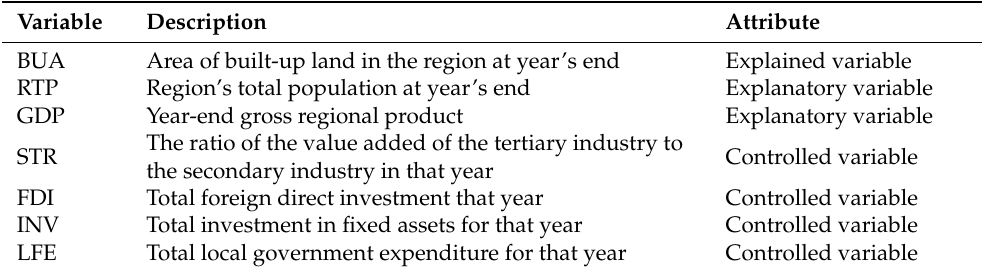
Table 1. Drivers and factors influencing urban